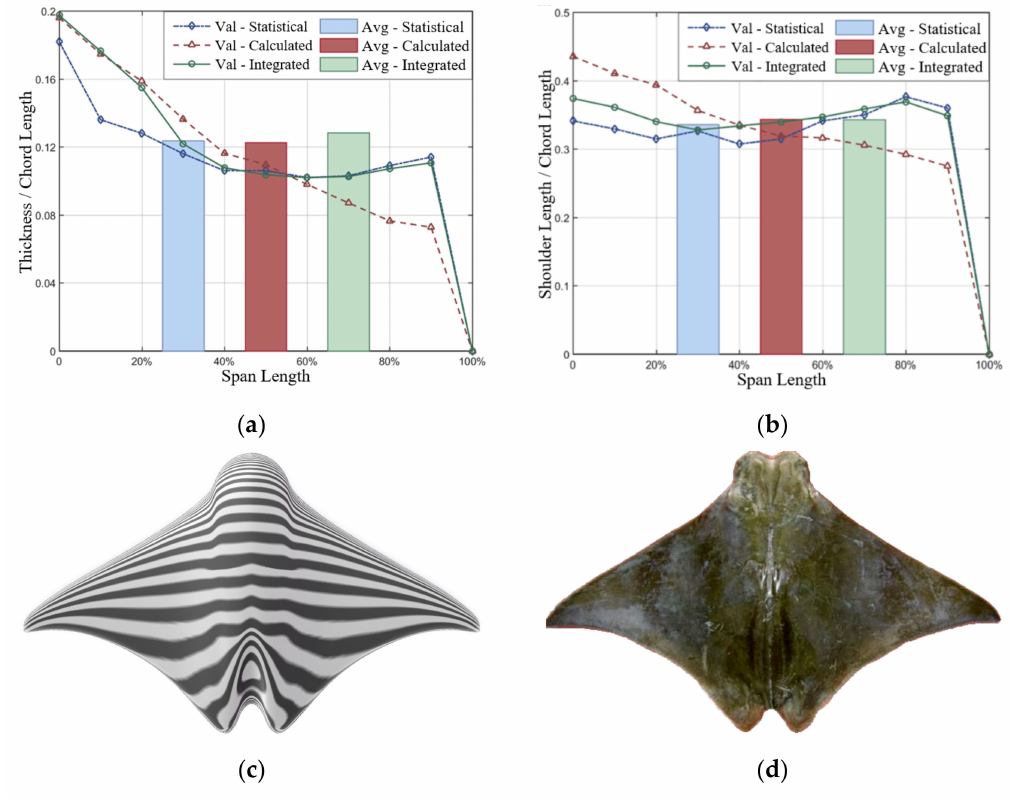
Figure 3. Evaluation of geometric precision. ( a ) Parameter conformance of T/C ratio; ( b ) parameter conformance of S/C ratio; ( c ) surface quality check with zebra stripes; ( d ) outline comparison with original